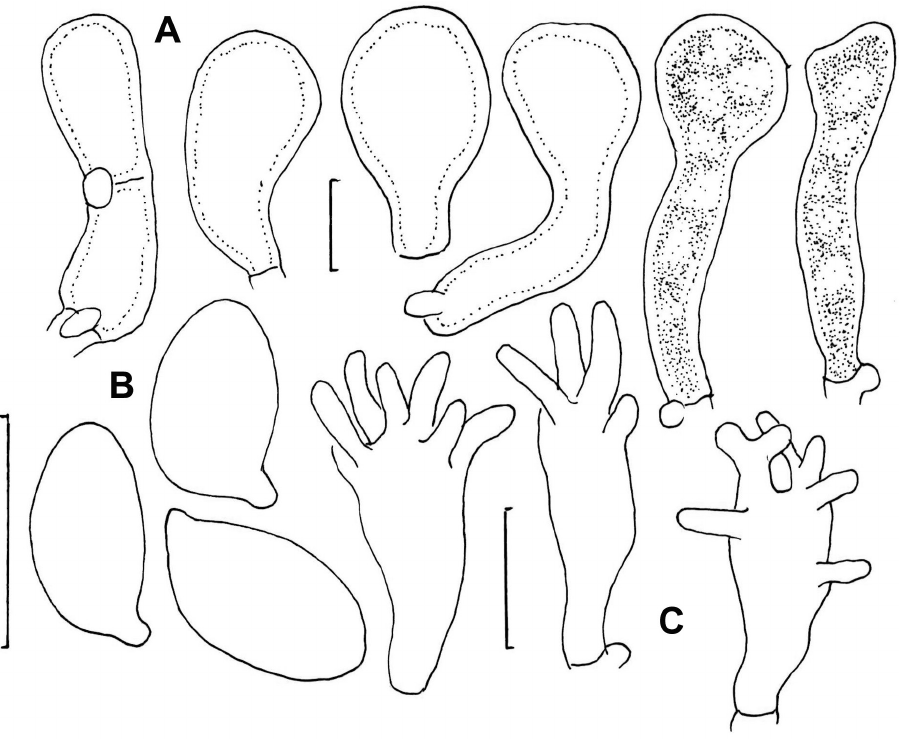
Figure 19. Mycetinis cinnamomeus . A Pileipellis elements B Basidiospores C Cheilocystidia. Standard bars = 10 µm. From Desjardin notes on AD